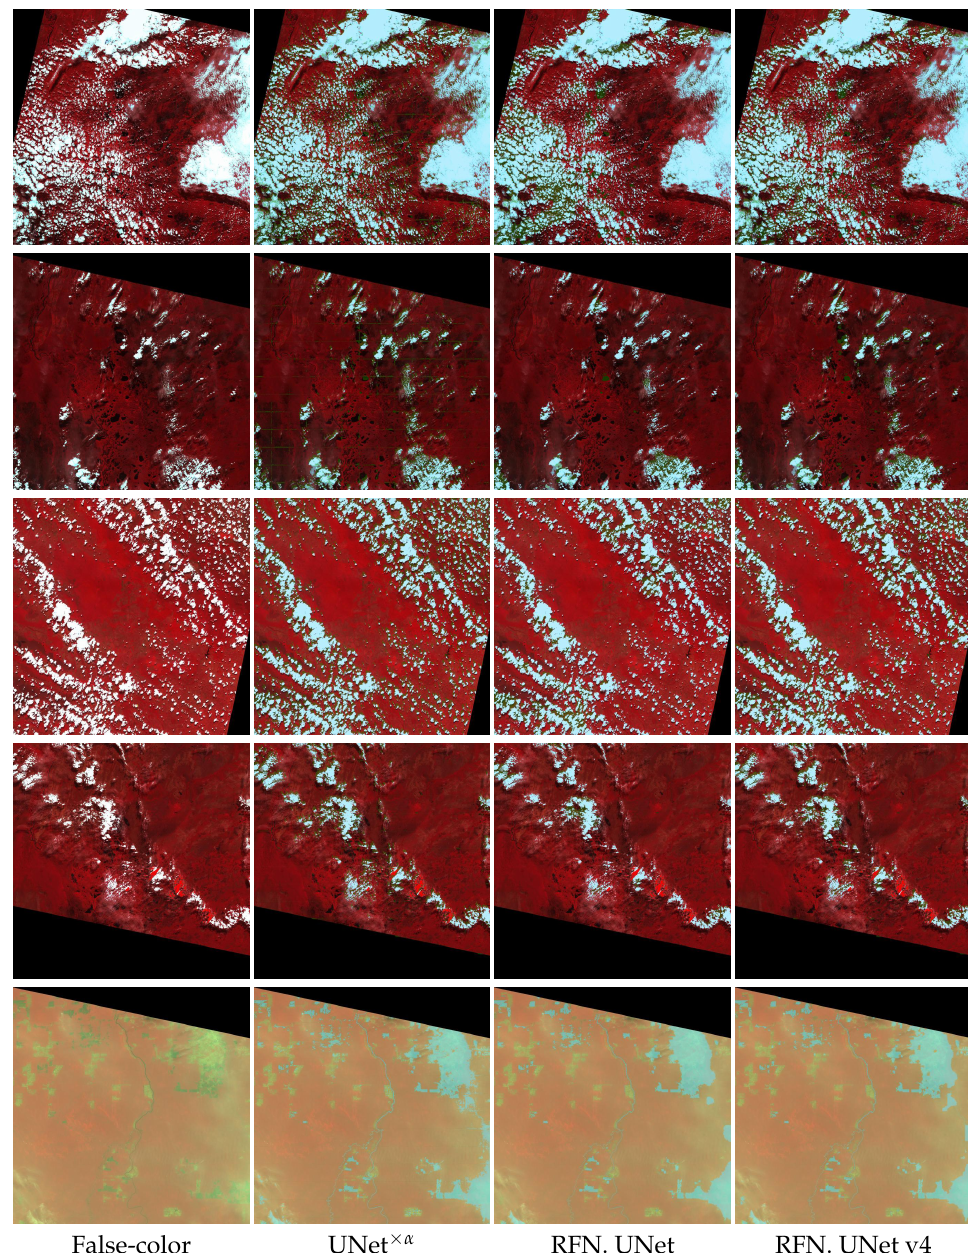
False-color UNet × α RFN. UNet RFN. UNet v4 Figure 2. Illustrations of segmentation proposals from a global perspective (1). Presented are the re- sults of 2014127221306.21KVB, 2014164221646.21KVB, 2014267223114.21LTD, 2017241224210.21KVB, and 2020262223057.20LQQ, respectively, including the false-color images (bands 4, 3, and 2) and the segmentation proposals of full resolution, yielded, respectively, by UNet × α , by our Refined UNet, and by v4. It can be seen that considerable cloud and shadow regions are generally detected and correctly labeled, confirming the effectiveness of the involved methods for cloud and shadow